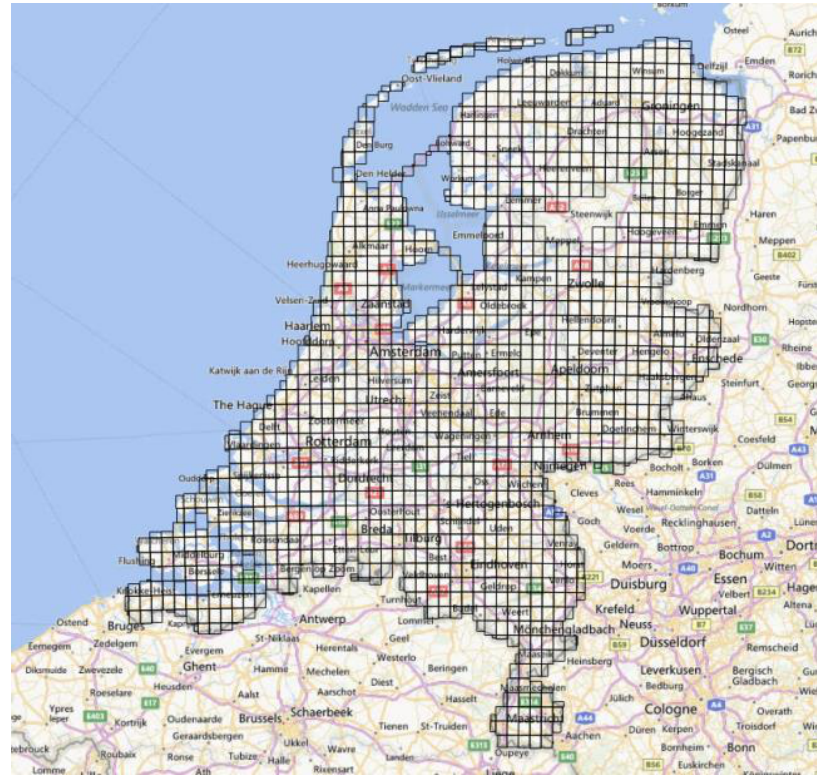
Figure 4: Bounding Polygons of the tiles of the AHN2 dataset displayed over a